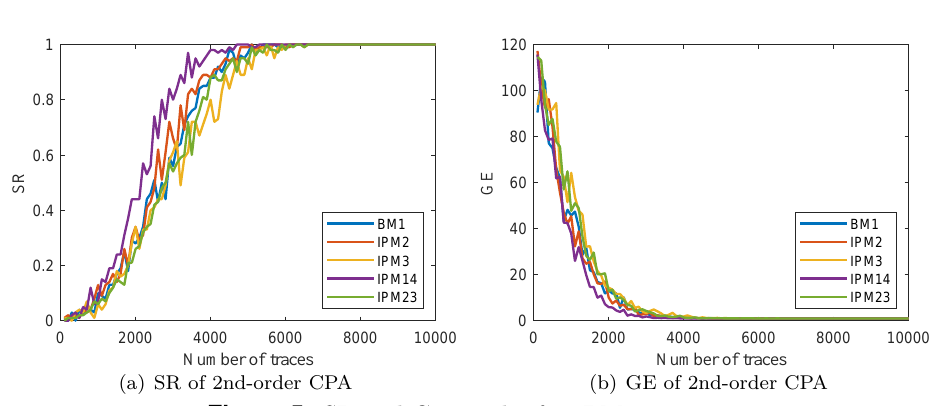
Figure 5: SR and GE results for IPM